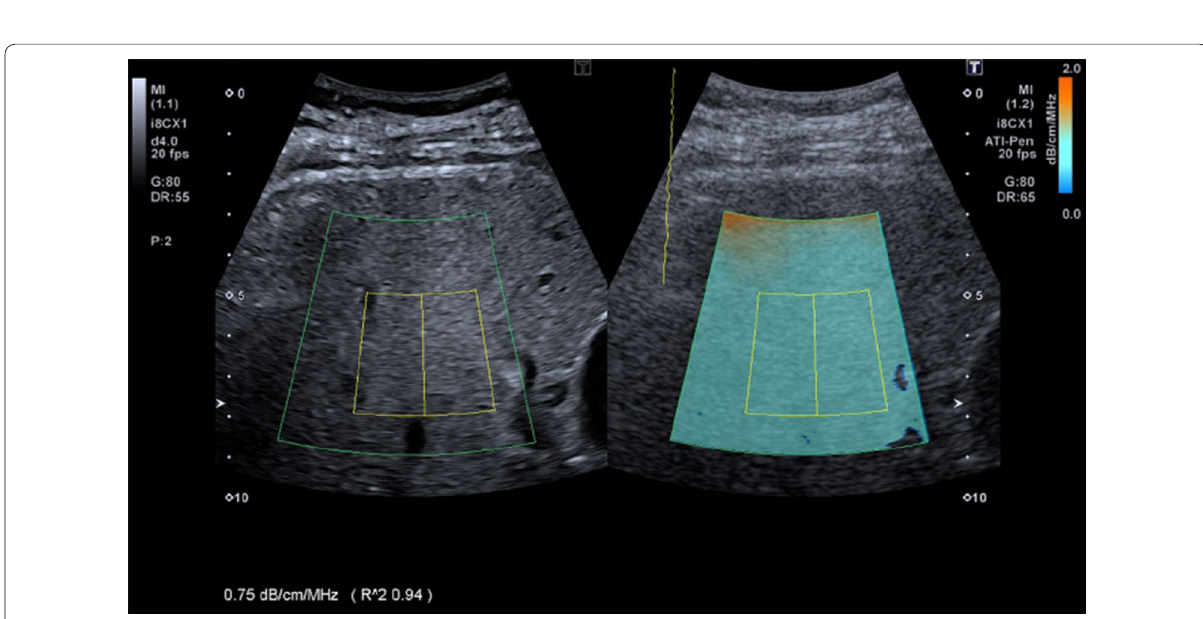
Fig. 13 Local attenuation map of a 55-year-old man with nonalcoholic fatty liver disease reporting a mean attenuation within the selected ROI of 0.75 dB/cm/MHz, indicating a stage 1 to 3 liver steatosis. Reproduced with permission from